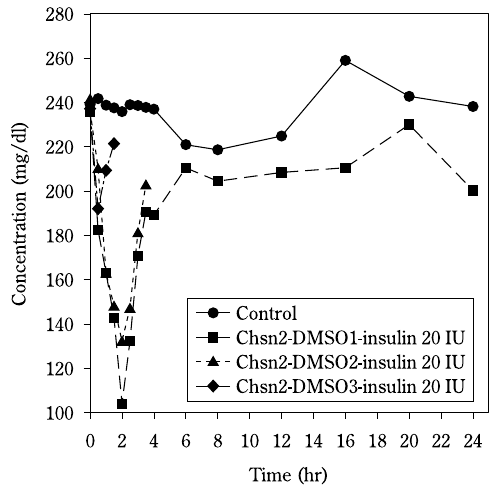
Fig. 8 Effect of DMSO molecular weight on blood glucose level of NOD-mouse in vivo . (DMSO1: 1.7 mg/ ㎖ , DMSO2: 0.85 g/ ㎖ , DMSO3: 3.4 g/ ㎖ ).